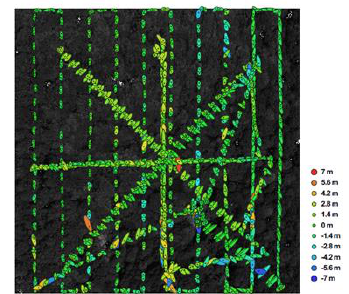
Figure 4. The block structure. Vertical image block composes of 10 flight lines in North-South direction. The oblique block consists of 4 bi-directional flight